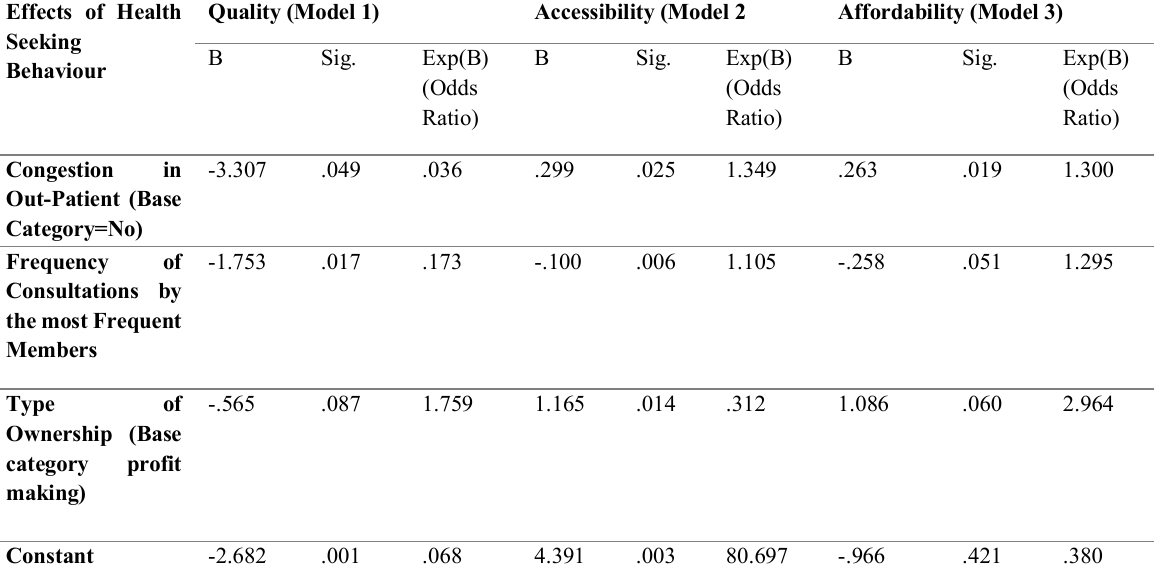
Table 3: Health Seeking Behaviour on Delivery of Effective Health